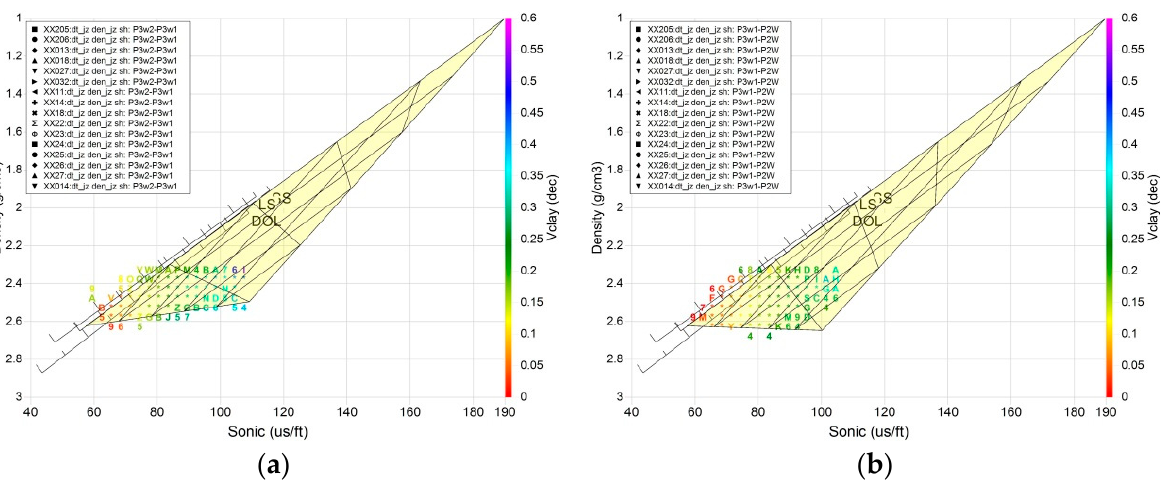
Figure 8. The acoustic-density crossplot method: ( a ) Wu 2 interval; ( b ) Wu 1 interval. Table 1. Parameters for the volume model.